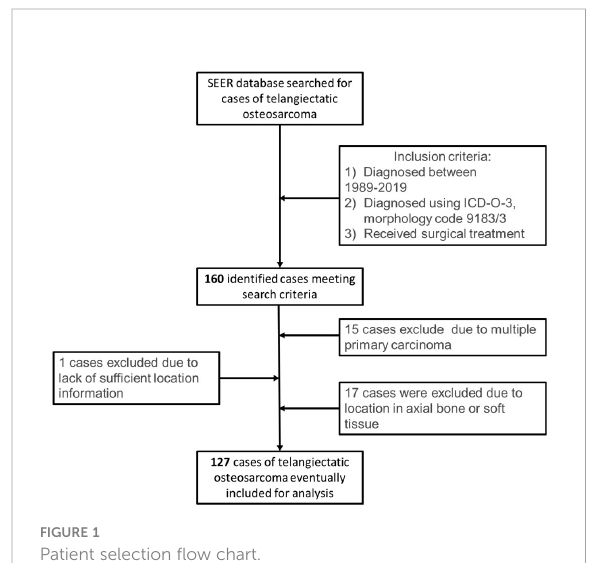
FIGURE 1 Patient selection fl ow